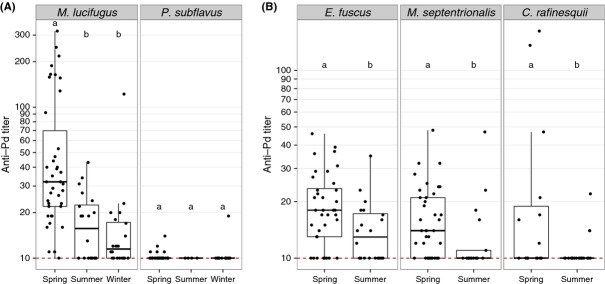
Comparison of anti-Pd antibody titers in five free-ranging bat species sampled in Kentucky, USA. (A) Anti-Pd titers were greater in little brown myotis (Myotis lucifugus) than in tri-colored bats (Perimyotis subflavus) (P < 0.05) and were greatest during the spring in little brown myotis. (B) Big brown bats (Eptesicus fuscus), northern long-eared myotis (M. septentrionalis), and Rafinesque's big-eared bats (Corynorhinus rafinesquii) had greater anti-Pd titers in spring than in summer, and all had lower titers than little brown bats in the spring (P < 0.05). Data are presented as quartiles, median (black line), and whiskers that represent 1.5 times the interquartile range. Titers ≤ 10 are considered negative for Pd reactive antibodies. Within each species, titers differed significantly between seasons not sharing common letters (P < 0.05).